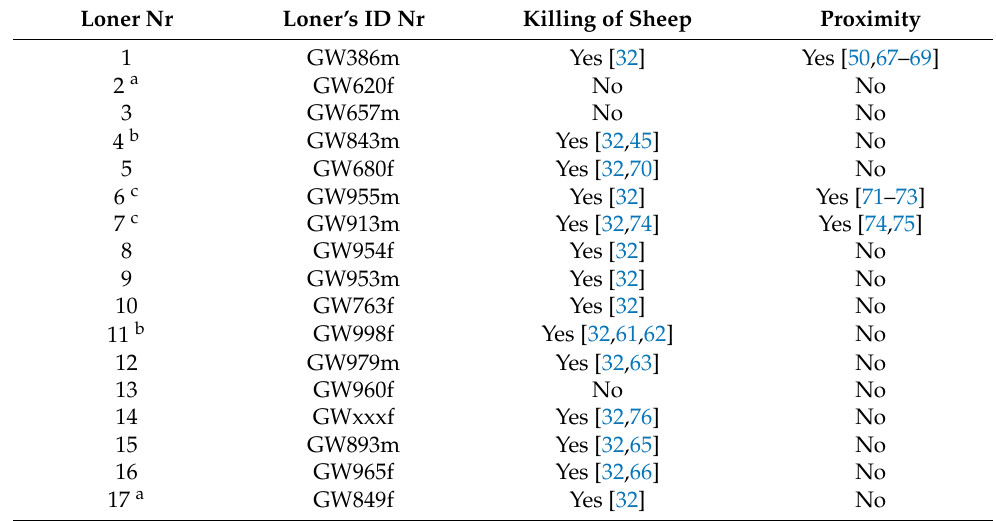
Table 2. Identified loners and references with evidence of killing sheep and proximity to humans within 6 months after the first detection in the Netherlands. Loner Nr Loner’s ID Nr Killing of Sheep Proximity